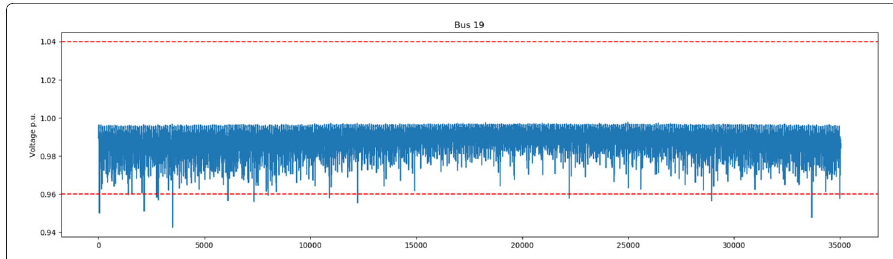
Fig. 8 Voltage curve of bus R18 for one year. The dotted lines are the voltage boundaries ±